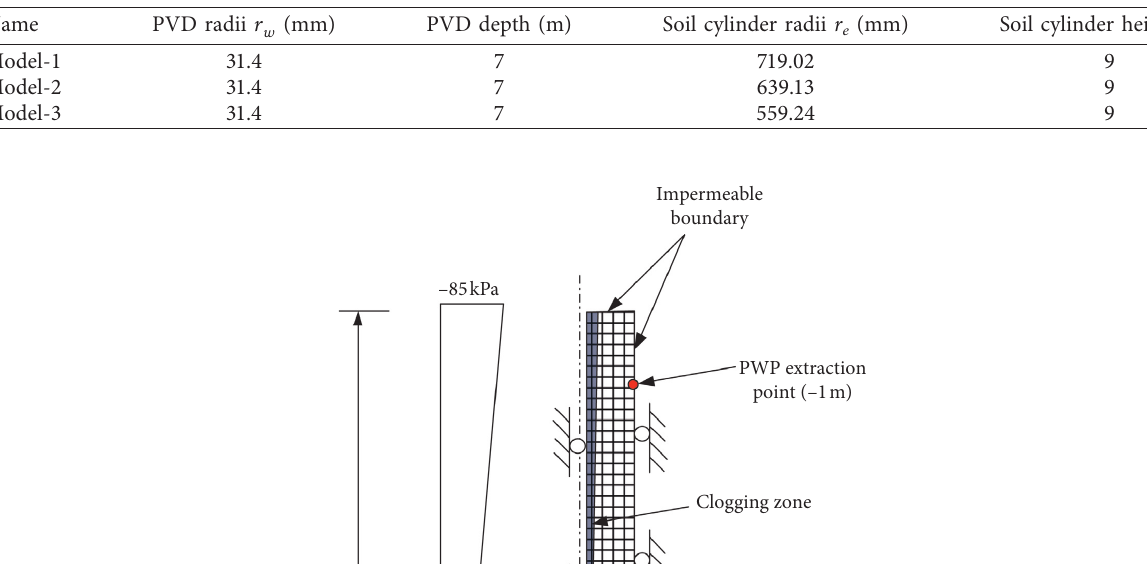
Table 4: Dimensions of finite element models.